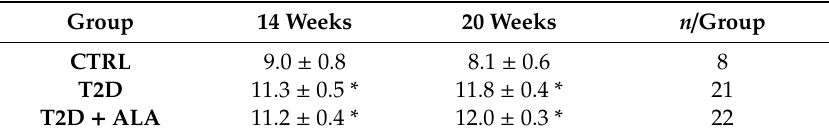
Table A1. Fasting Blood Glucose.